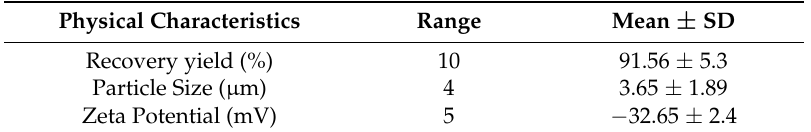
Table 2. Physical characteristics of the gonorrhea vaccine microparticles. The recovery yield (%) after the spray drying process, particle size, and the zeta potential were measured in triplicates and mean and the standard deviation are reported along with the range.